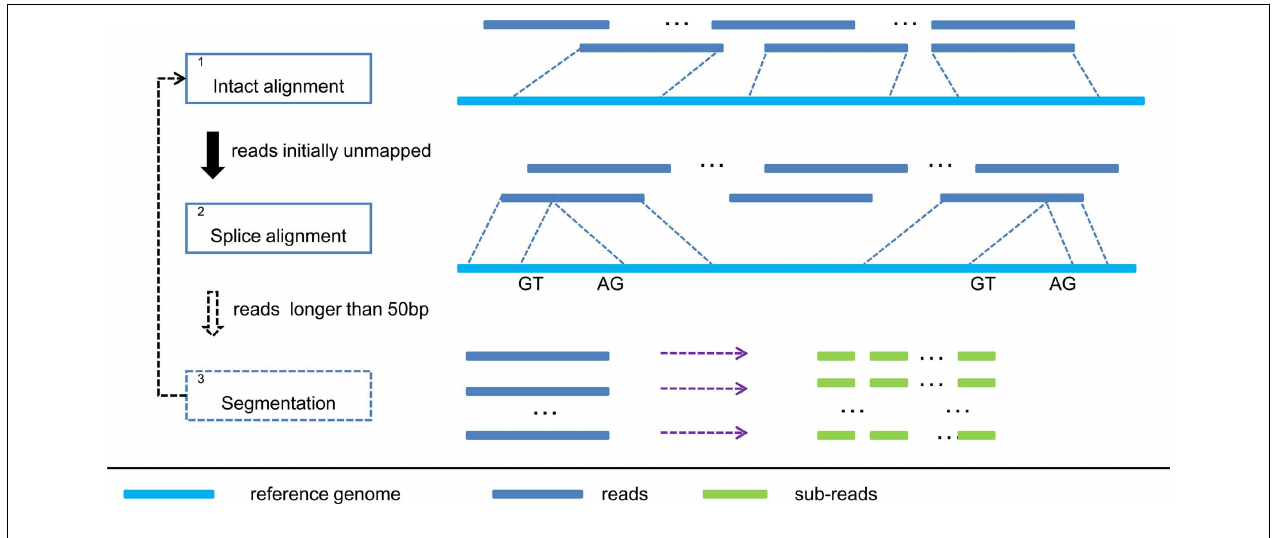
FIGURE 1 | Pipeline of SOAPsplice. In step 1, SOAPsplice maps complete reads to the reference genome using BWT index.Then in step 2, SOAPsplice aligns IUM reads to the reference genome by using two-segment alignment